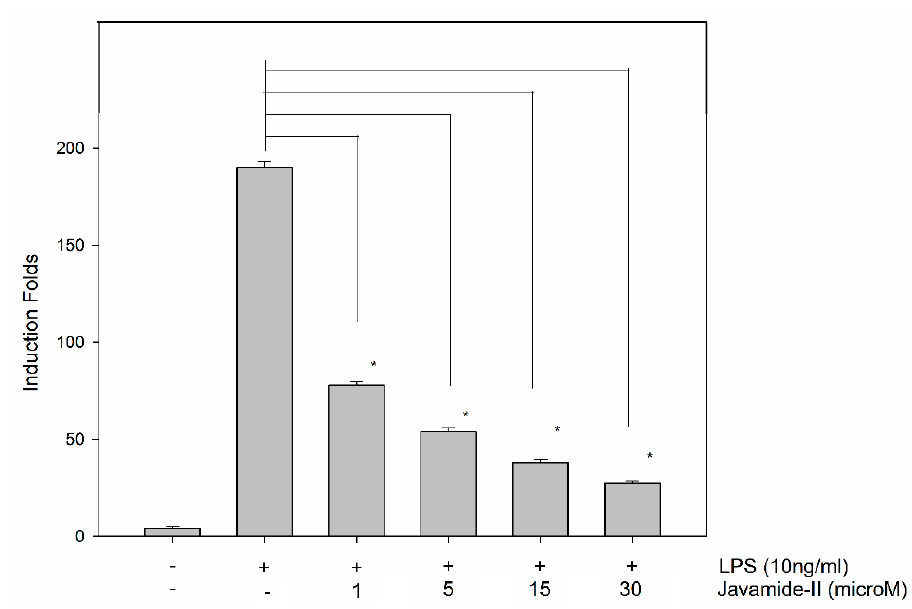
Figure 7. The effect of javamide-II on IL-6 mRNA. PMA-differentiated THP-1 cells were treated with javamide-II (0. 1, 5, 15, 30 µM) followed by treatment with LPS for 4 h as described in “Materials and Methods”. After 4 h, total RNA was isolated and gene expression was determined using (RT)-PCR. Data are expressed as mean ± SD ( n = 3). The asterisks (*) indicate significant difference from vehicle control ( P < 0.002).